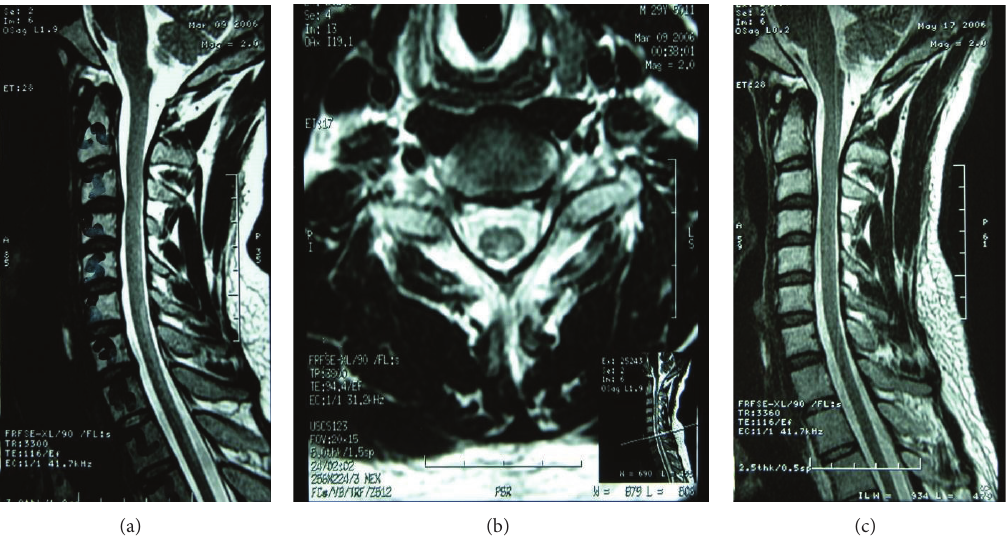
Figure 2: ((a), (b)) Sagittal and axial T2 magnetic resonance images on patient admission showed T2 hyperintensity of the posterior columns. (c) Sagittal T2 magnetic resonance images 2 months later showed striking reduction of the MRI abnormalities.